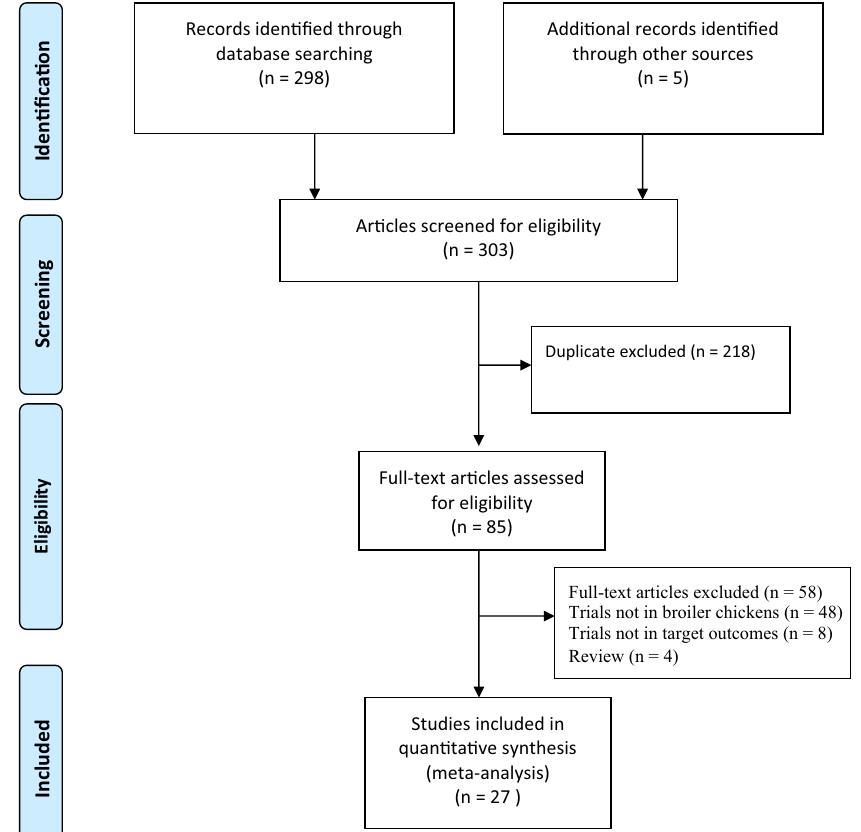
Figure 1: Study selection fl ow chart used for the meta -